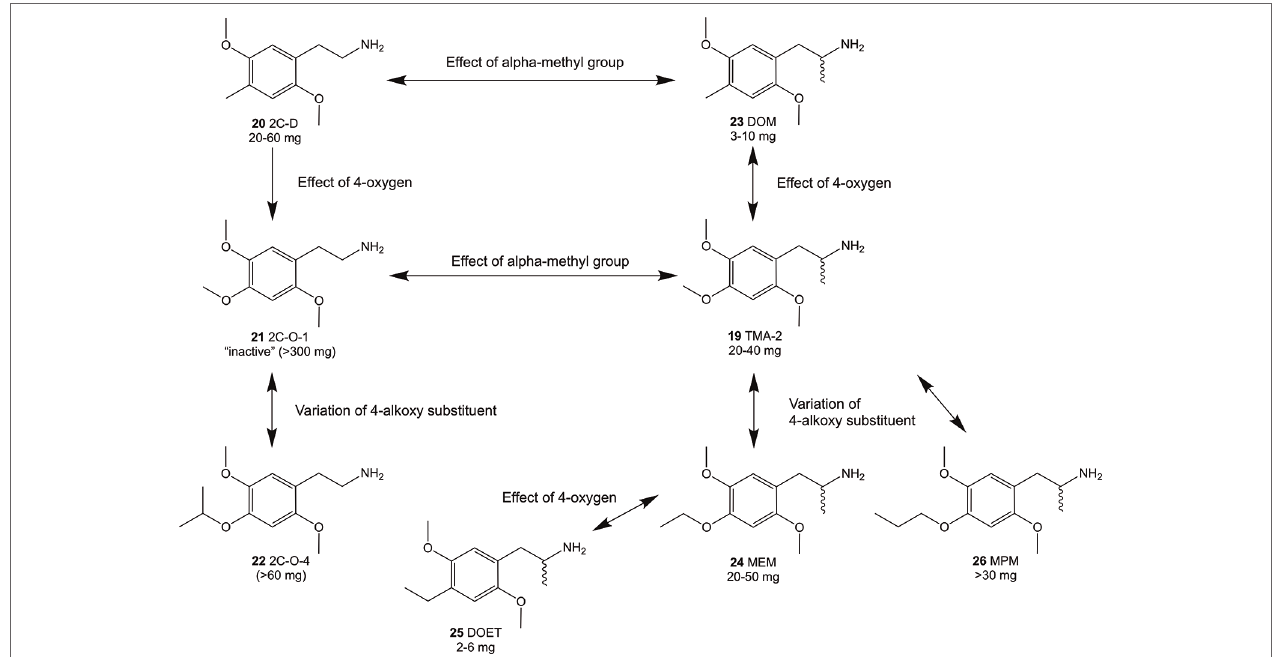
FIgURe 3 | Summary of Shulgin’s early findings on structural modifications and their relation to psychoactive oral doses in humans using phenethylamines and amphetamines related to the 2C-O and 3C-O compounds. Doses were taken from PiHKAL (Shulgin and Shulgin, 1991). In general, an alpha-methylation (compounds 23 and 19 ) of the 4-substituted 2,5-dimethoxy compounds increased the psychoactive potency while addition of 4-oxygen decreased potency (compounds 21 and 19 ).